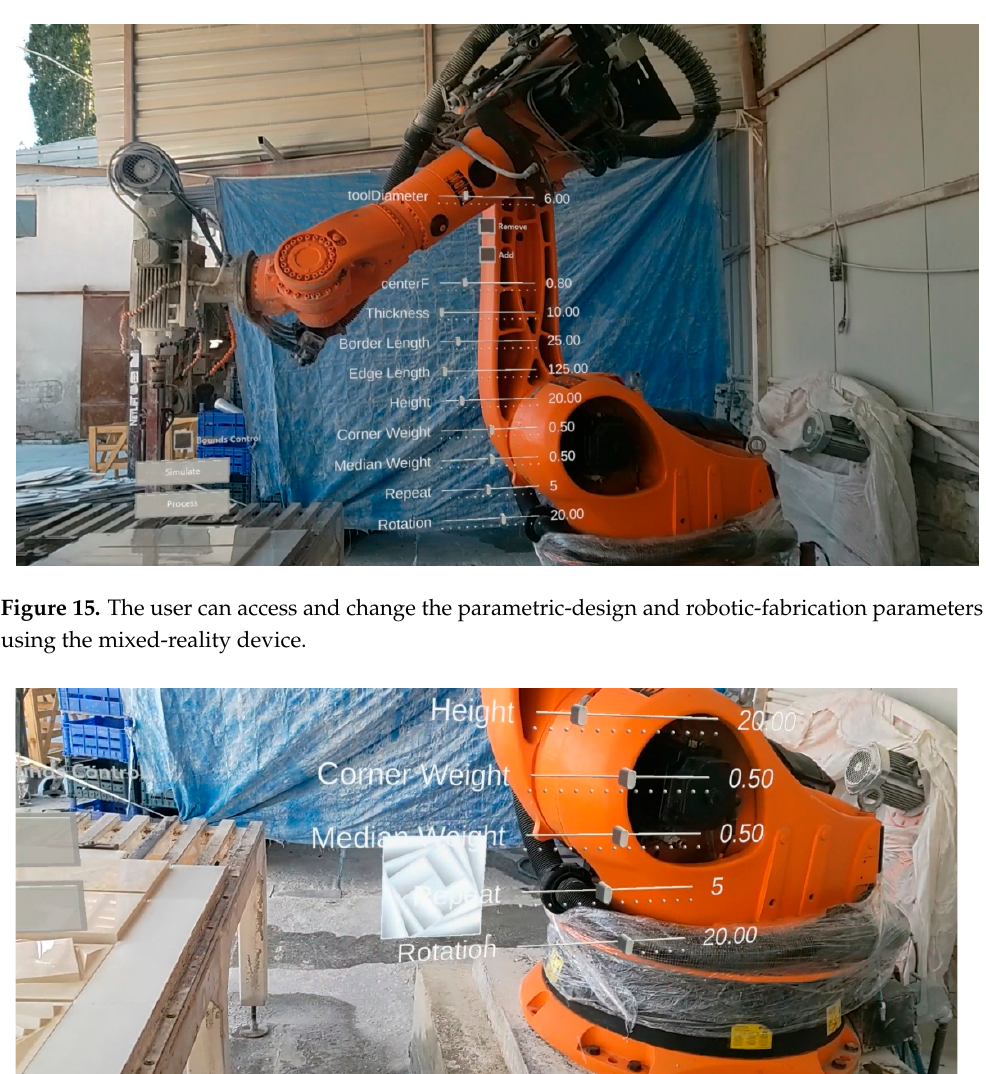
Figure 17. The results of each iteration, generated by applying different transformation rules, de- fined with corner-weight , median-weight , height , and rotation parameters at each iteration, and the re- sult of the termination rule at the last iteration. Figure 18 shows the production results of design products defined with the shape- grammar method. There are nine different natural stone products in the figure. Eight pro- duction results were manufactured with existing methods using parametric-modeling tools. The product located at the center was manufactured with the proposed method, and